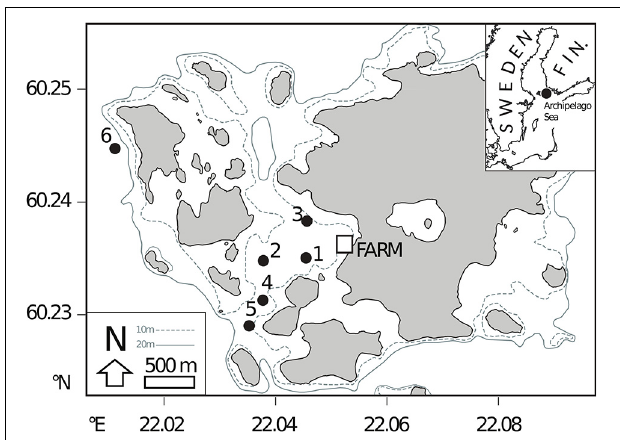
FIGURE 1 | Locations of field sites used for sediment sampling near a former rainbow trout farming site in the Archipelago Sea (Baltic Sea,